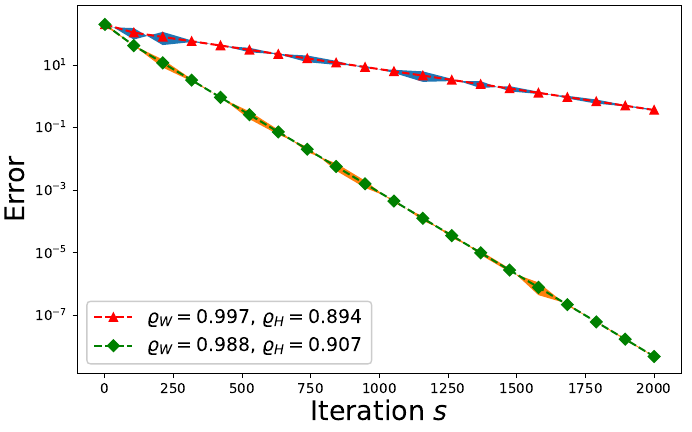
Figure 4. The effect of (cid:36) W on the convergence of a random consistent system. On the other hand, consider an inconsistent system. One has to apply Algorithm 2 to solve it. The entries of W , H , and c are drawn from an independently